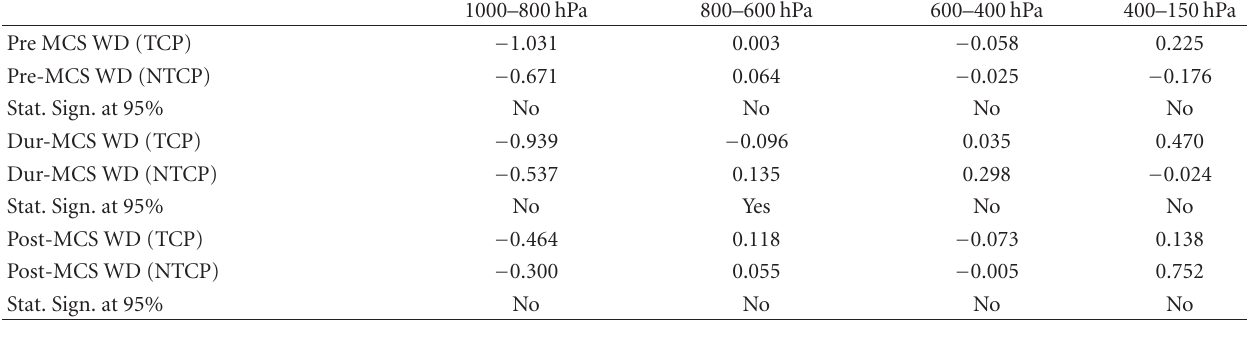
Table 7: Same as Table 6 except for directional (WD) wind shear ( ◦ hPa − 1 ).